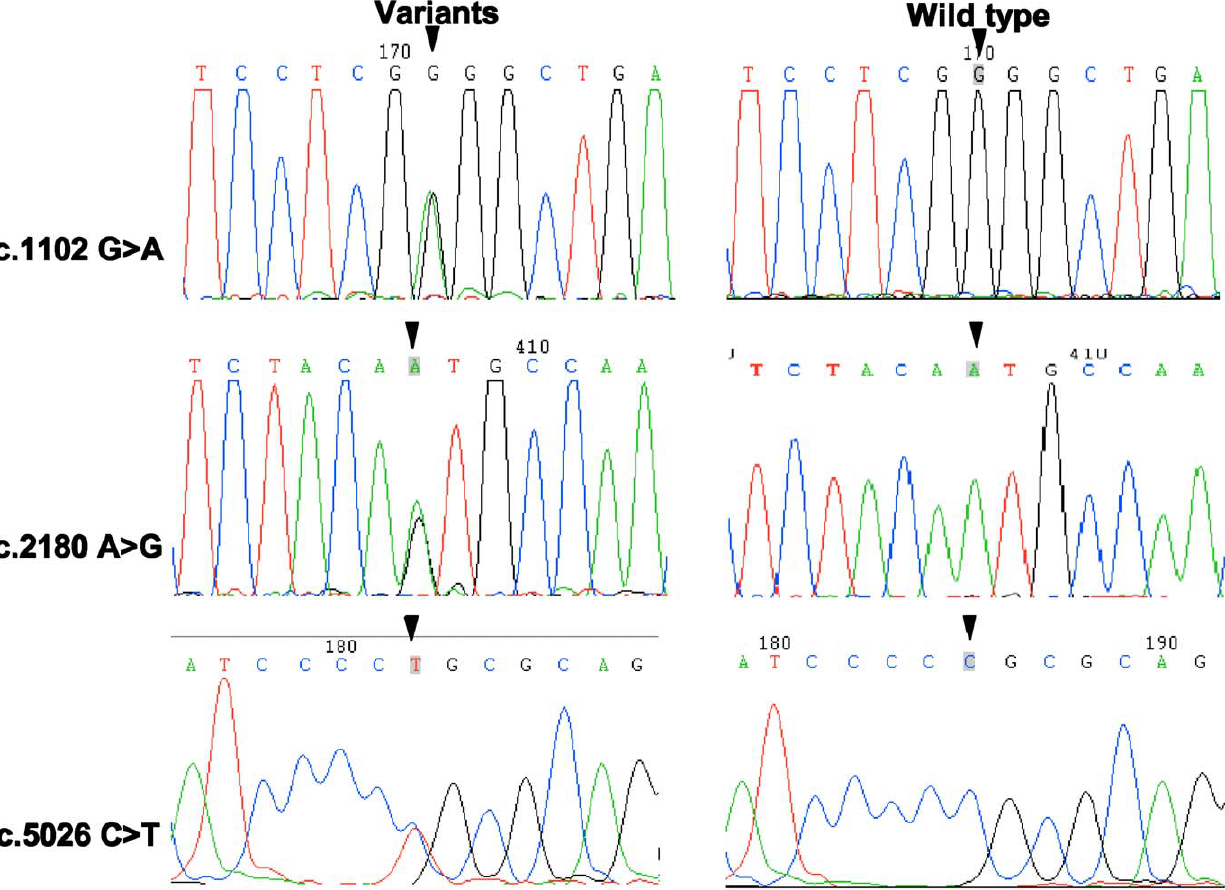
Figure 3. Sequencing chromatograms of novel missense mutations identified in the present work with wild type control. The variants include c.1102G . A, c.2180A . G and c.5026C . T. Corresponding variant locations are arrowed.